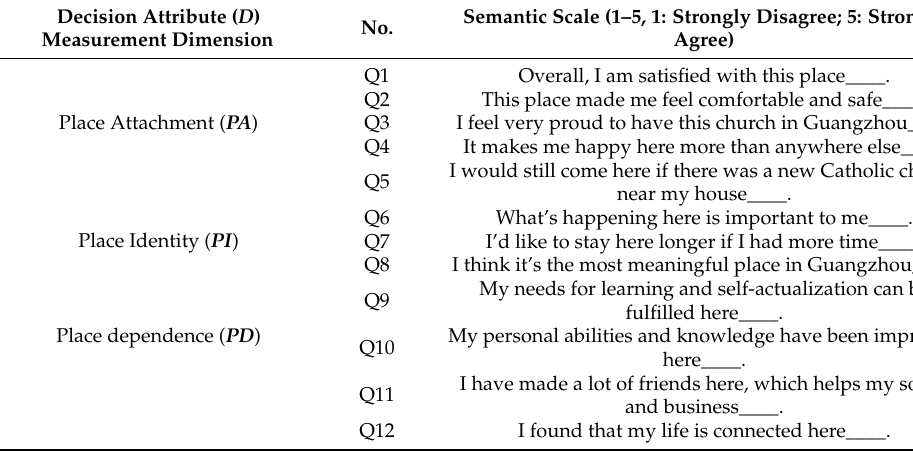
Table 1. Measured items under each dimension.